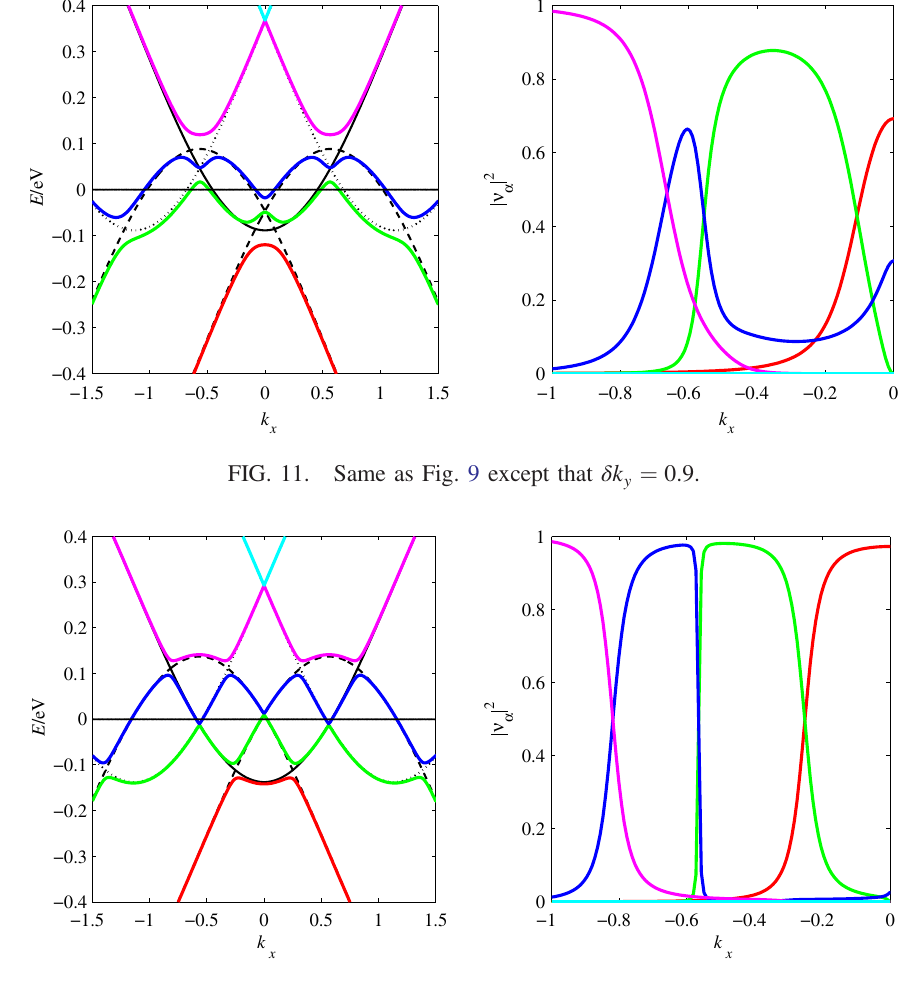
FIG. 12. Same as Fig. 9 except that δ k y ¼ 1 . 2 .